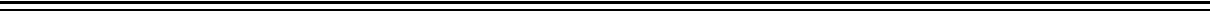
Table 1. Well-being and ecosystem services vary substantially over these four scenarios, which differ according to their evolution of policies, ecosystem services, and